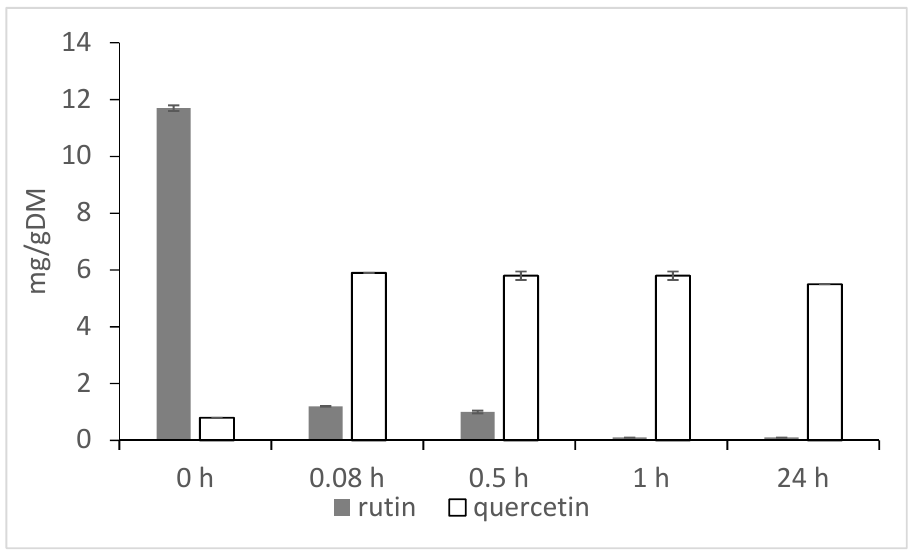
Figure 1. Rutin transformation to quercetin in buckwheat flour under condition of 44% water in the mixture [25].